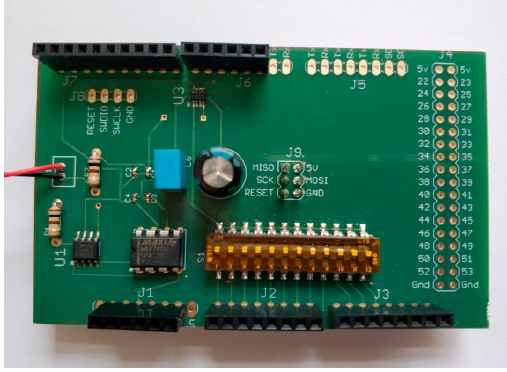
Figure 4. Example of an SCC with welded components.